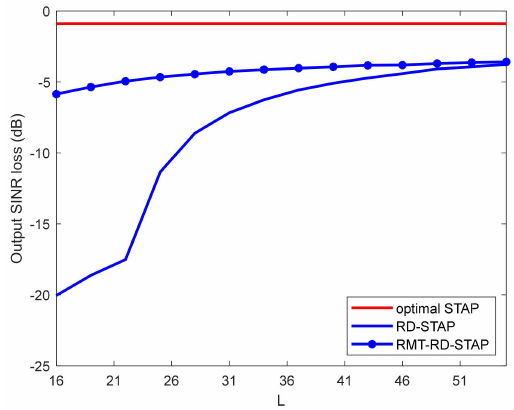
Figure 5. Output SINR losses versus the number L of the training